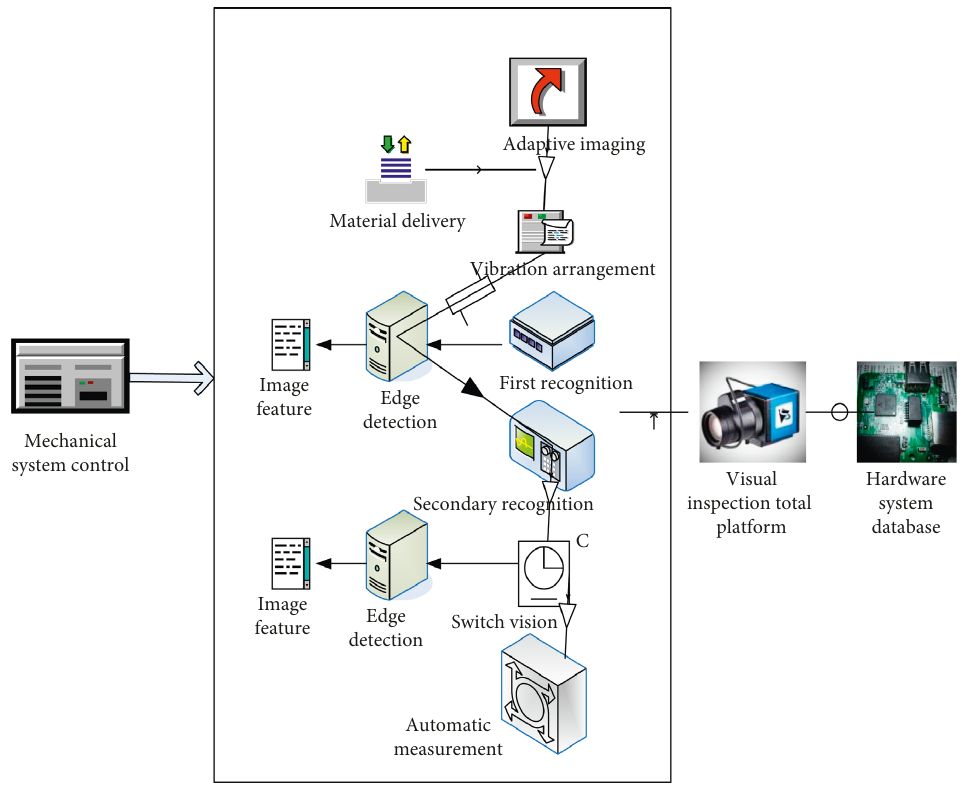
Figure 1: Machine vision automatic measurement. Table 1: Camera parameters.